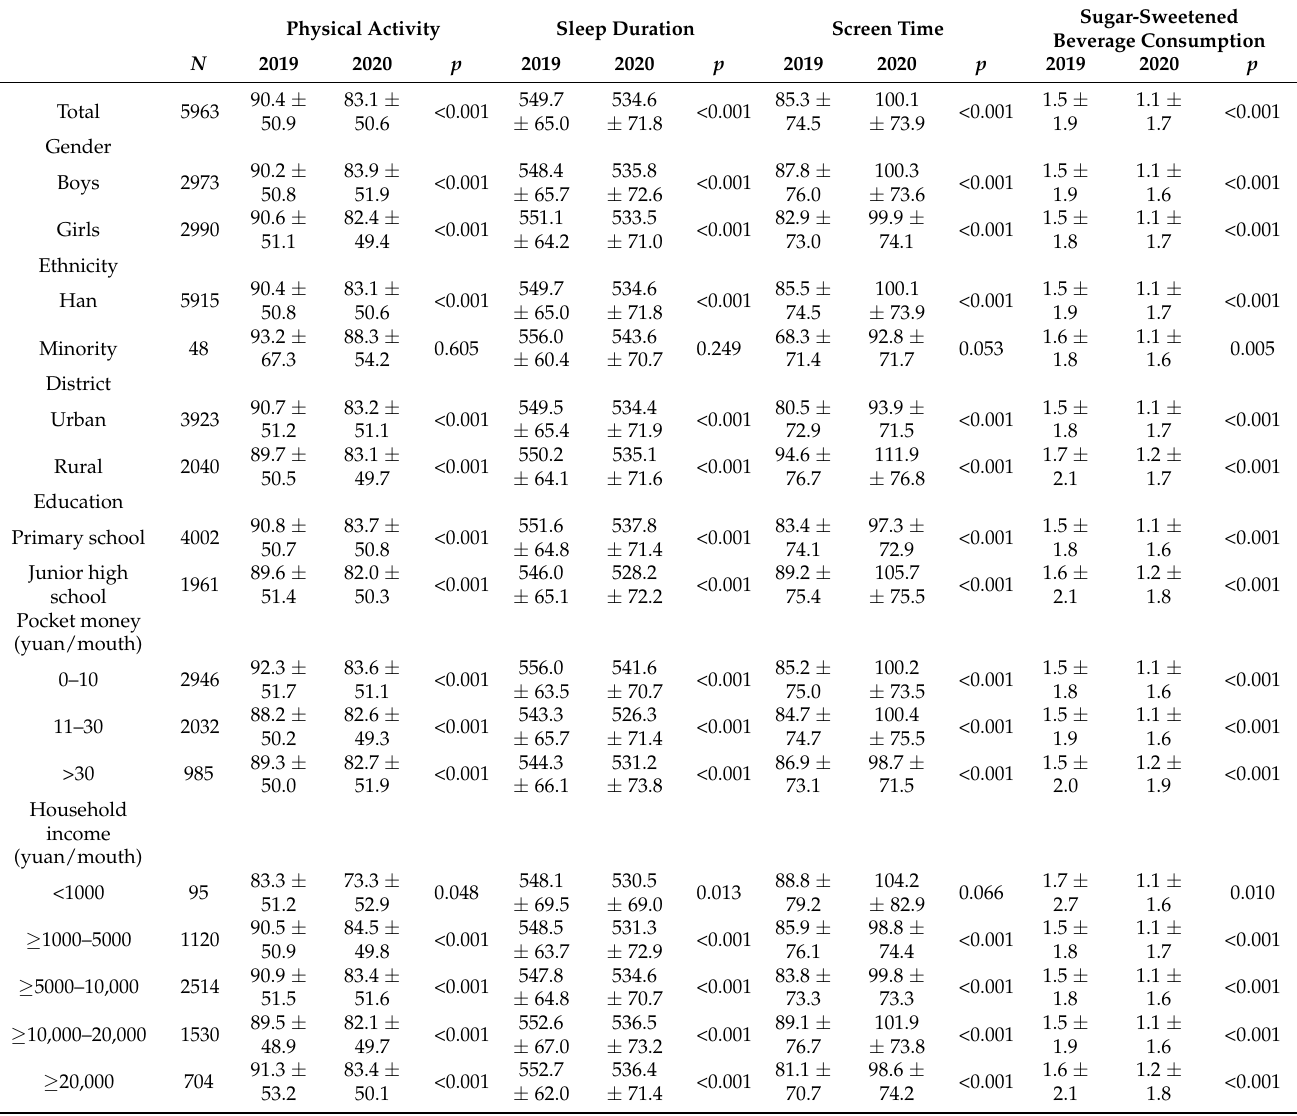
Table 3. Changes in weight-related behaviors before and during the